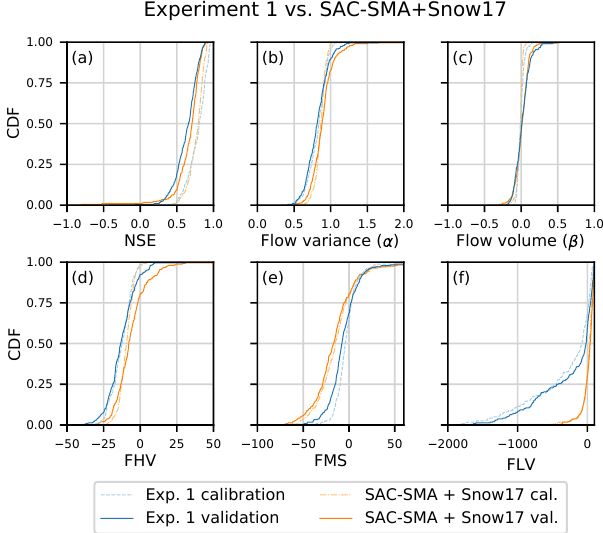
Figure 8. Cumulative density functions for various metrics of the calibration and validation period of Experiment 1 compared to the benchmark model. FHV is the bias of the top 2% flows, the peak flows, FMS is the slope of the middle section of the flow duration curve and FLV is the bias of the bottom 30% low flows.